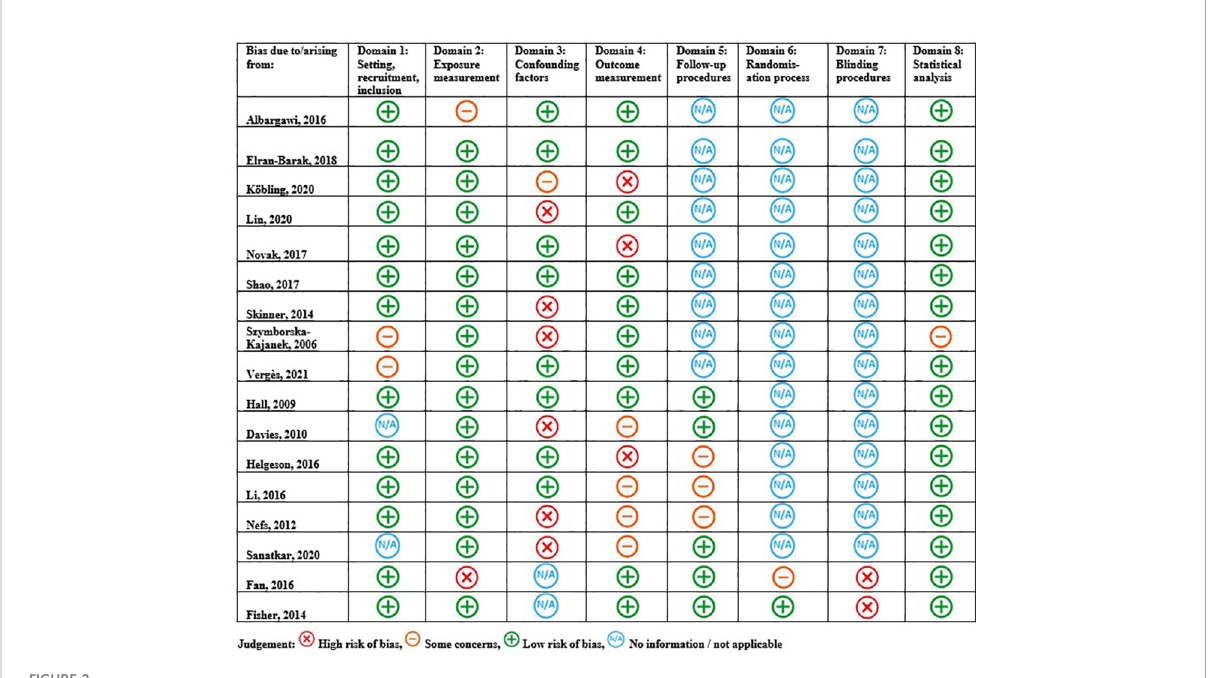
FIGURE 2 Risk of bias and quality assessments for included